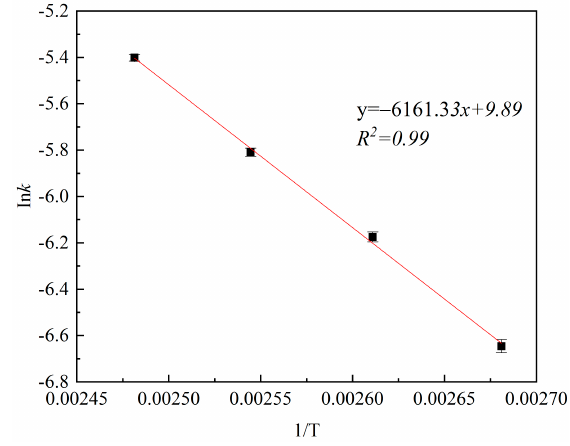
Figure 4. Relationship between 1 − (1 − 2 α /3) − (1 − α ) 2/3 and time at different temperatures.